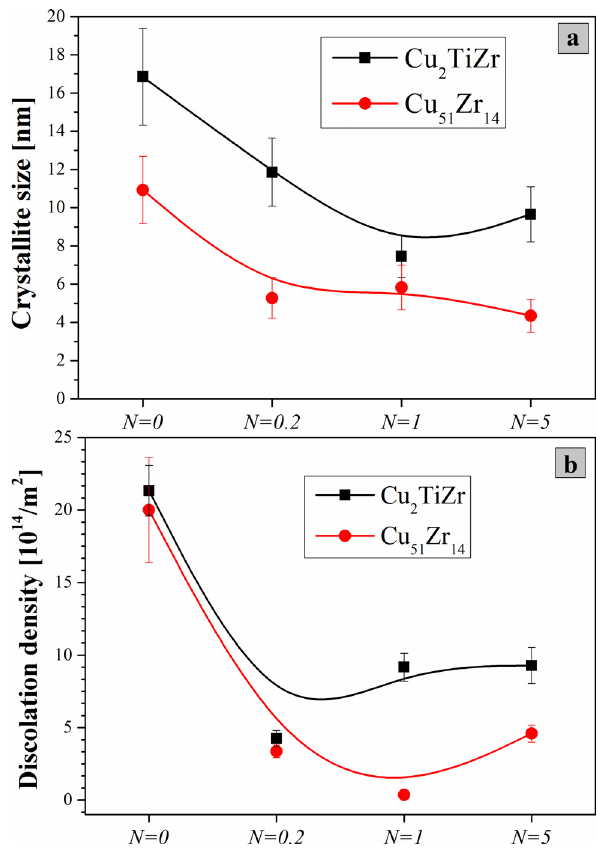
Figure 7: (a) Crystalline size ⟨ D ⟩ and (b) dislocation density ( ρ ) of the Cu 2 ZrTi and Cu 51 Zr 14 phases determined by the CMWP fit for the different deformed